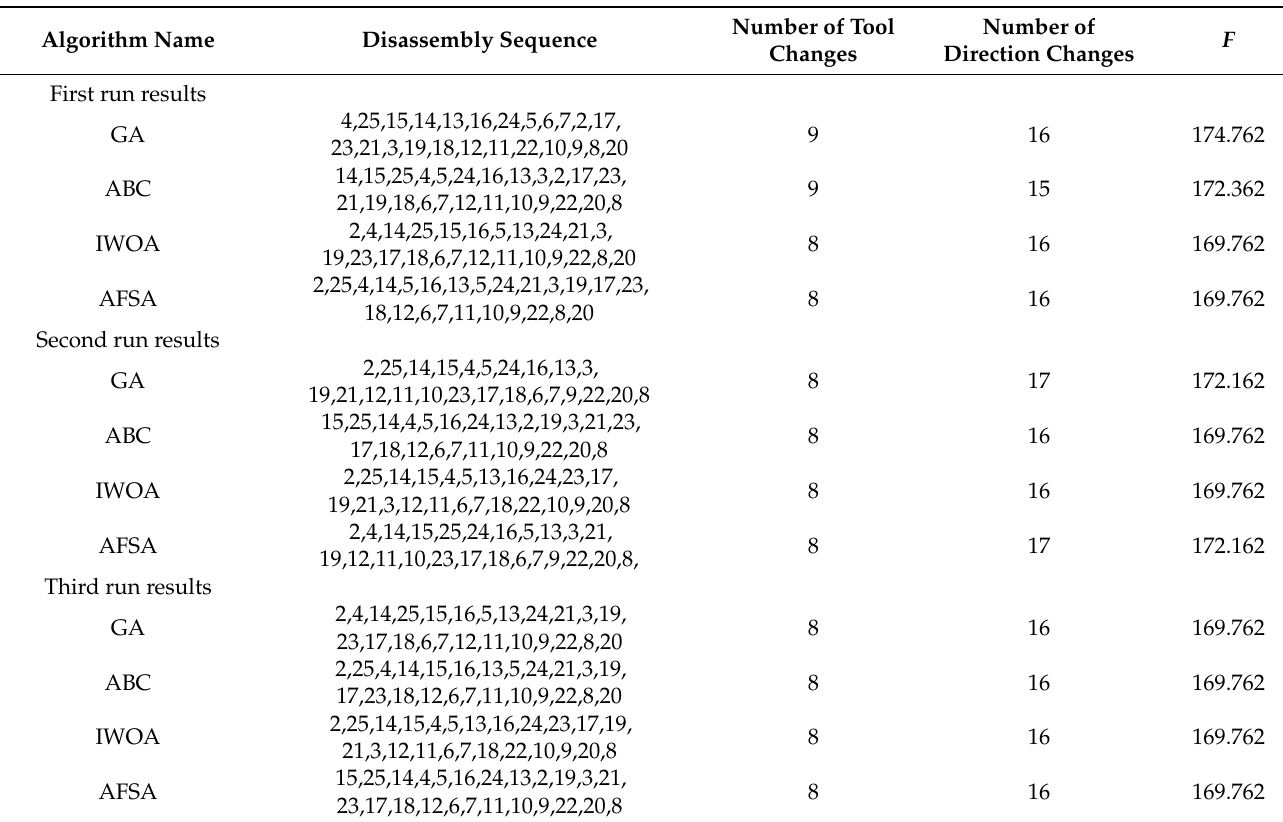
Table 3. Different disassembly sequences for the four